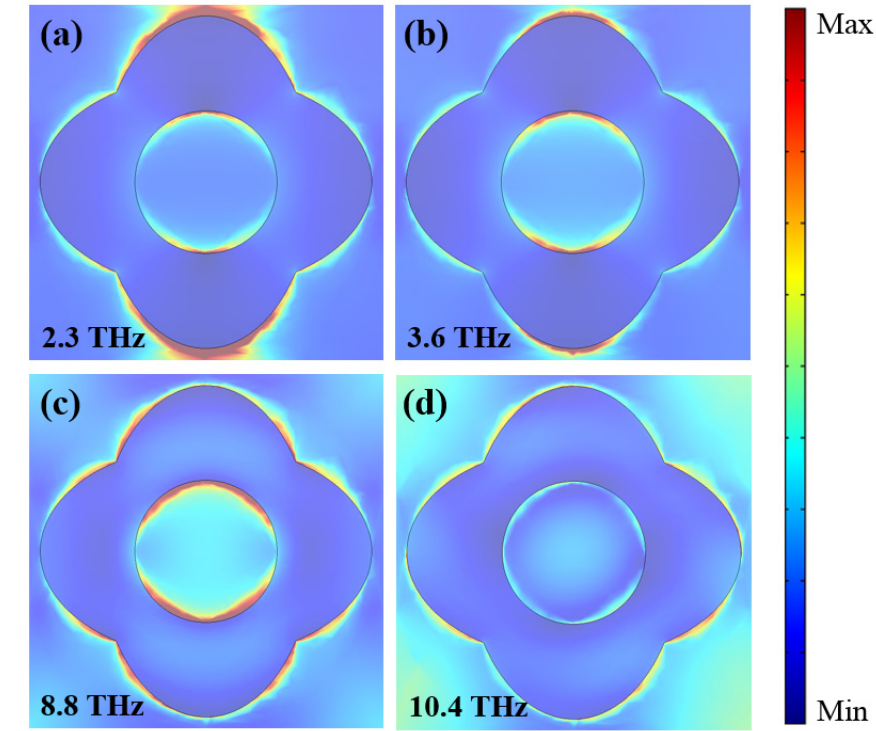
Figure 5. The electric field distribution in the top view at 2.3 THz ( a ), 3.6 THz ( b ), 8.8 THz ( c ) and 10.4 THz ( d ).